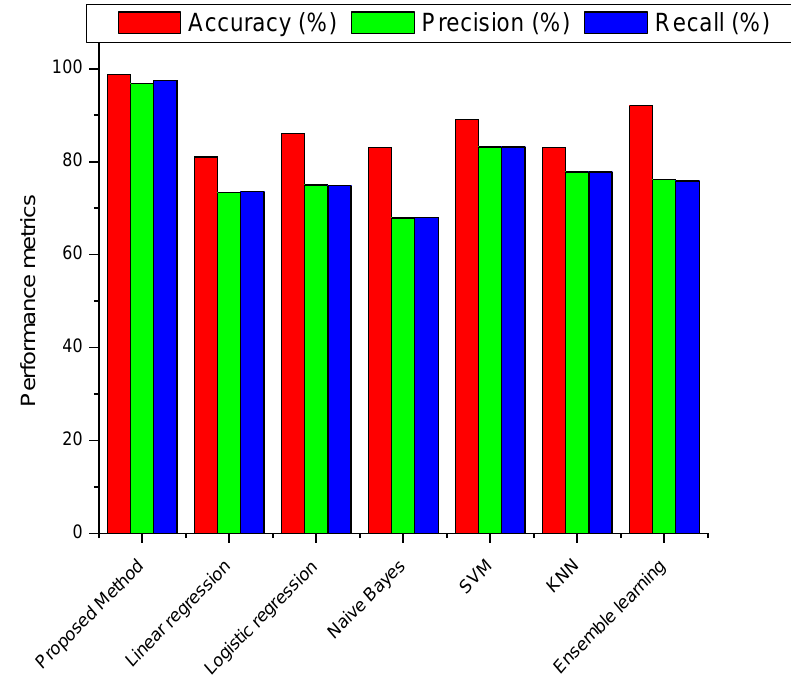
Figure 12. Comparison of performance metrics with currently used methods.